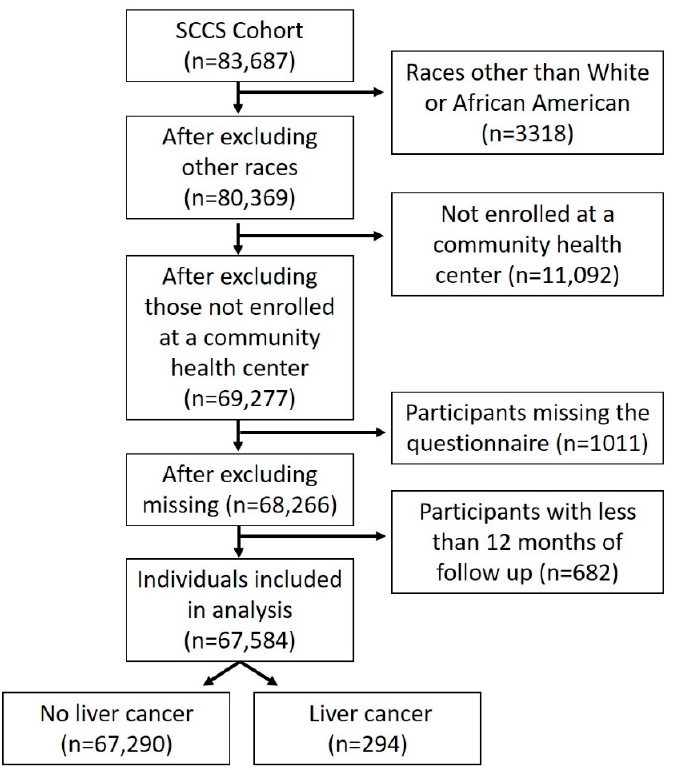
Figure 1. Flow chart of study participants. Exclusion and inclusion criteria are shown.